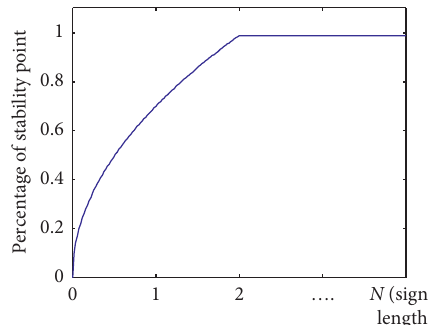
Figure 2: Percentage trend chart of stability points.